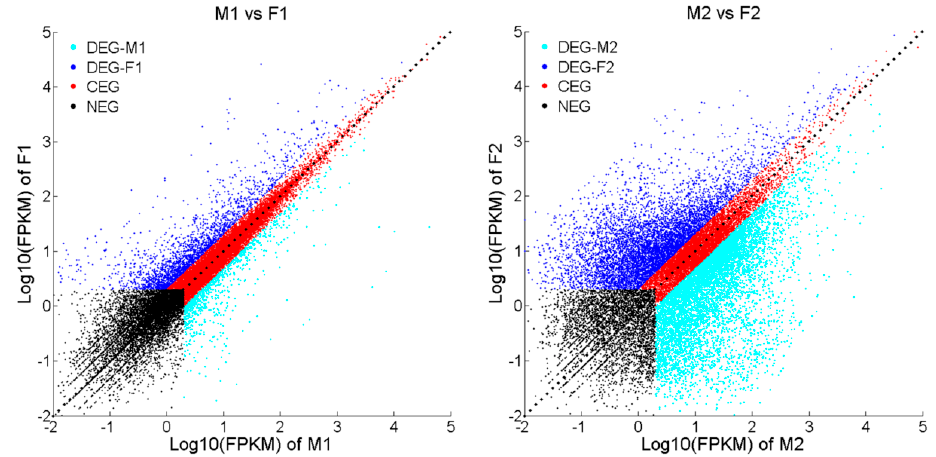
Figure 2. Gene expression profiling in brain tissue between male and female tongue sole at two developmental stages. Non-expressed genes (NEGs) marked as black dots. Differentially expressed genes (DEGs) marked as dark blue and light blue dots. Co-expressed genes (CEGs) marked as red dots.